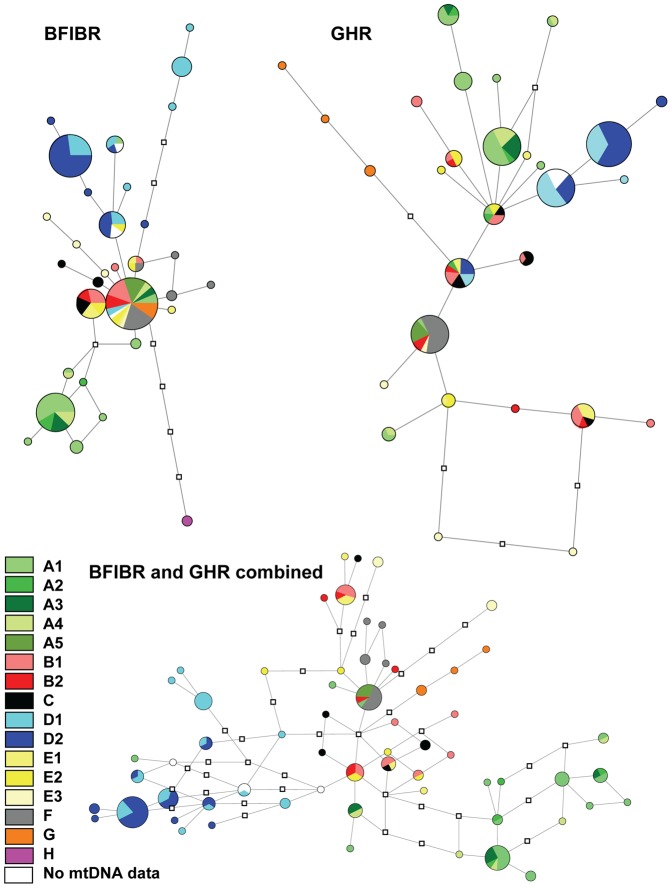
Minimum spanning networks of L. aenigmamus nDNA haplotypes (BFIBR, GHR and BFIBR+GHR combined).Circle sizes are proportional to the number of similar haplotypes observed in the data set. Branch lengths are proportional to the number of mutations between haplotypes. Colors refer to each clade or subclade identified in the phylogenetic analysis. Missing haplotypes are represented by a white square.